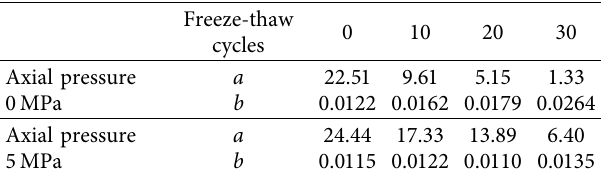
Table 3: a and b values of strength and strain rate of samples with different freeze-thaw